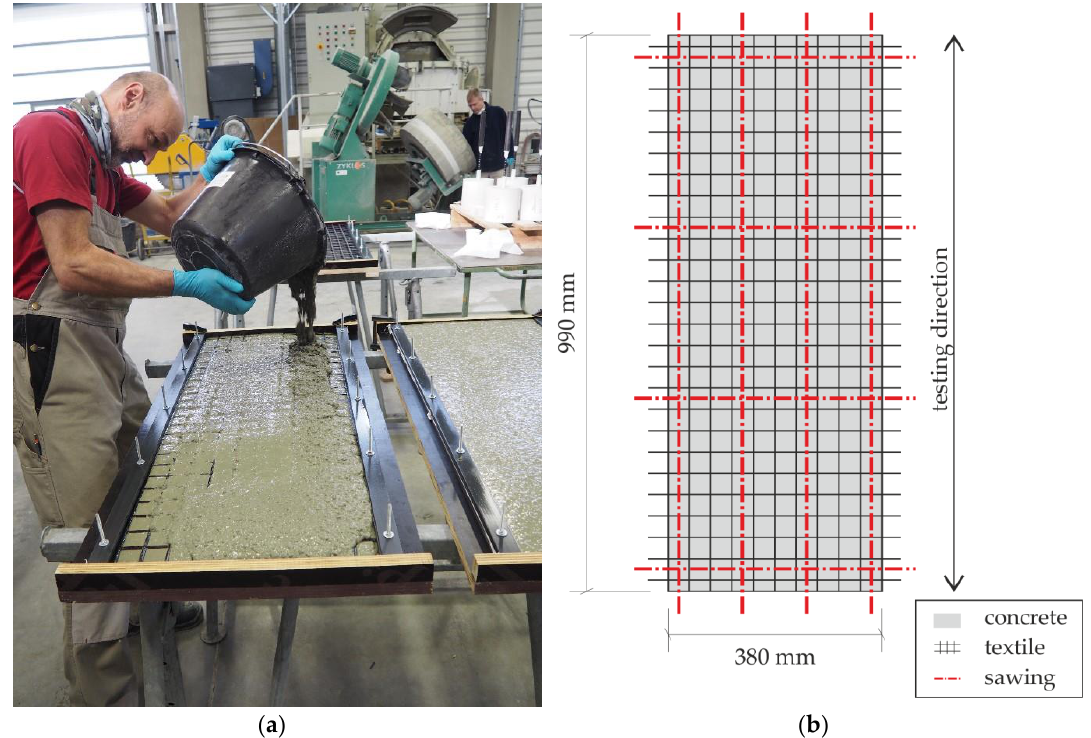
Figure 2. Manufacturing of the specimens: ( a ) Casting of huge panels; ( b ) Sawing out of specimens (exemplary cut). Appl. Sci. 2019 , 9 , x FOR PEER REVIEW